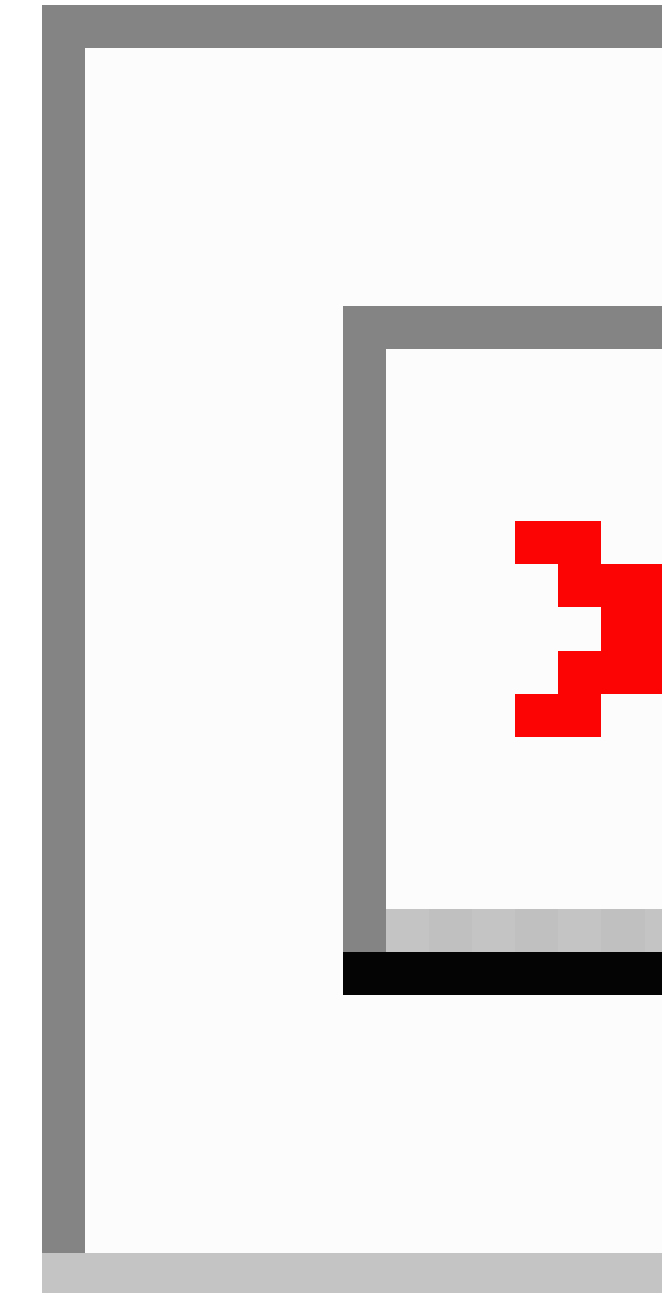
Figure 2. A screenshot of the NeuroVR 2 open-source